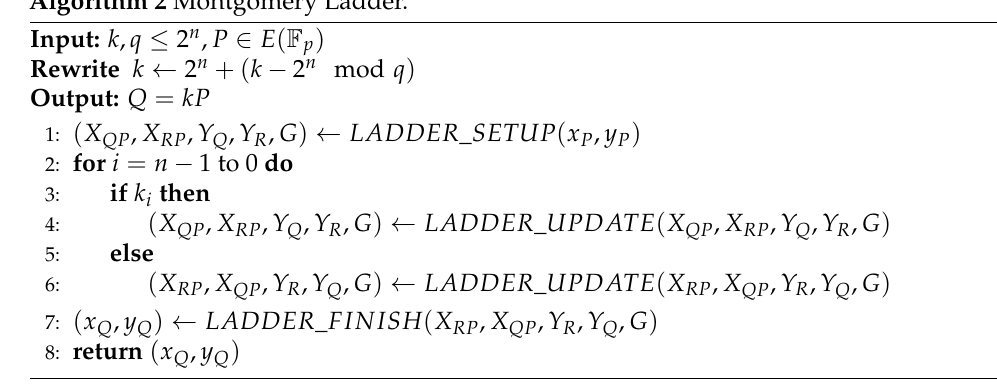
Algorithm 2 Montgomery